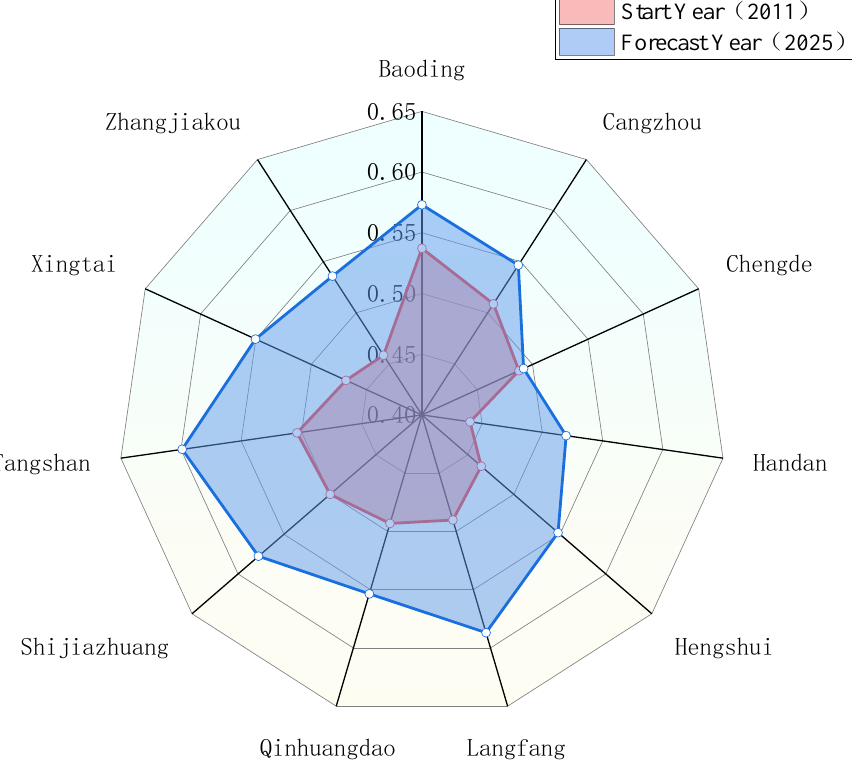
Figure 8. Comparison of coupling coordination degrees between 2011 and